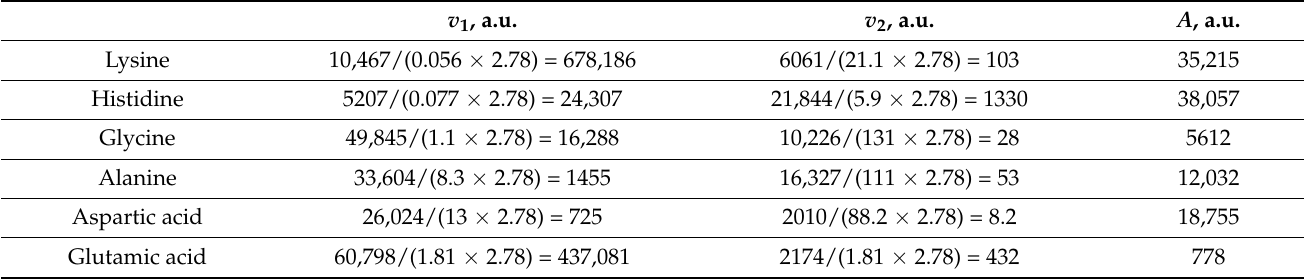
Table 2. The rates v 1 and v 2 of decay of the luminescence intensity and the values of free constants A for suspensions of amino acids in ordinary water. v 1 , a.u. v 2 , a.u. A , a.u.